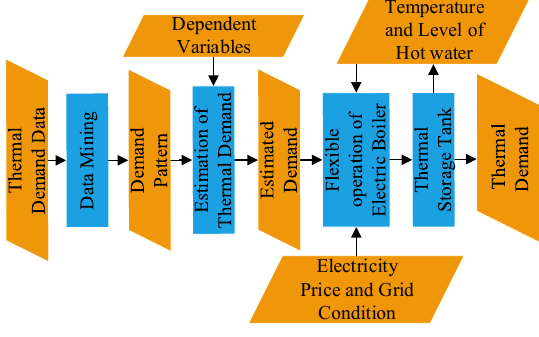
Figure 1. Block diagram of proposed system for flexible operation of electric